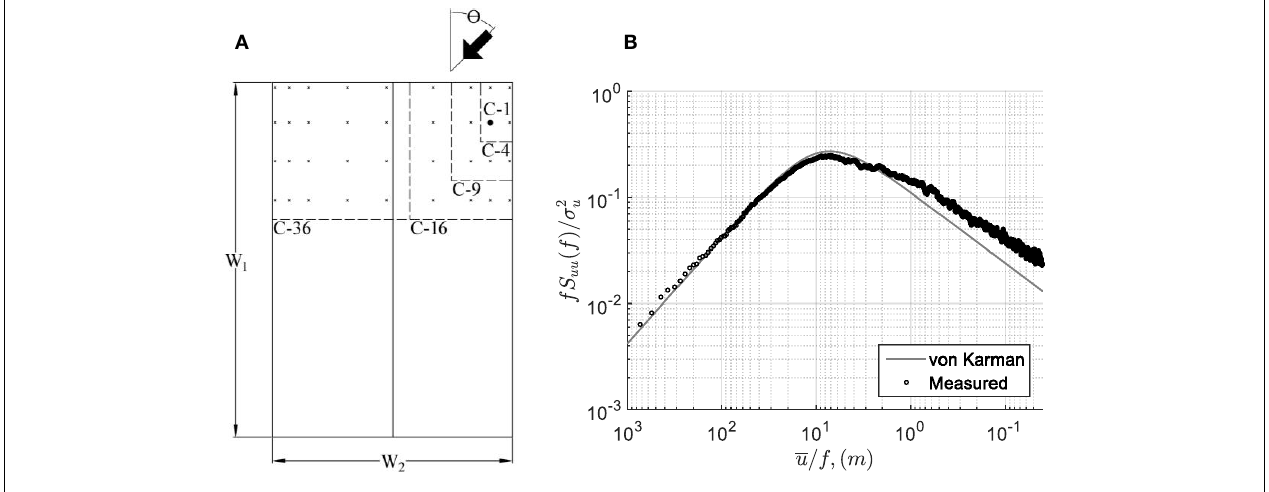
FIGURE 2 | E[C p ] obtained from each mean wind azimuth (cid:22) θ (cid:22) θ (cid:22) θ along with the resulting C p ( θθθ ) described by Eq. 7 for pressure tap, C-1 .